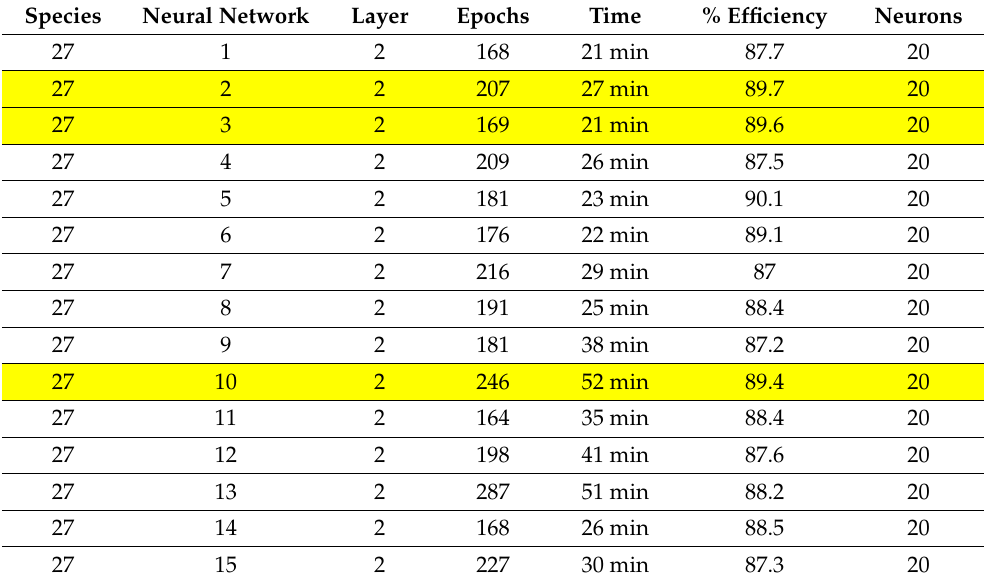
Table 5. Third experiment. Fifteen runs of the neural network with 27 species and 20 neurons in the hidden layer.